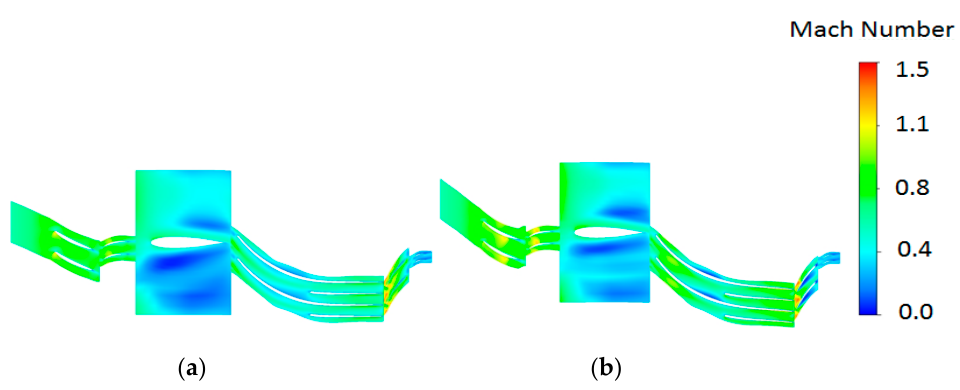
Figure 13. Design point Mach number distribution (5% blade span): ( a ) baseline; ( b ) optimized .